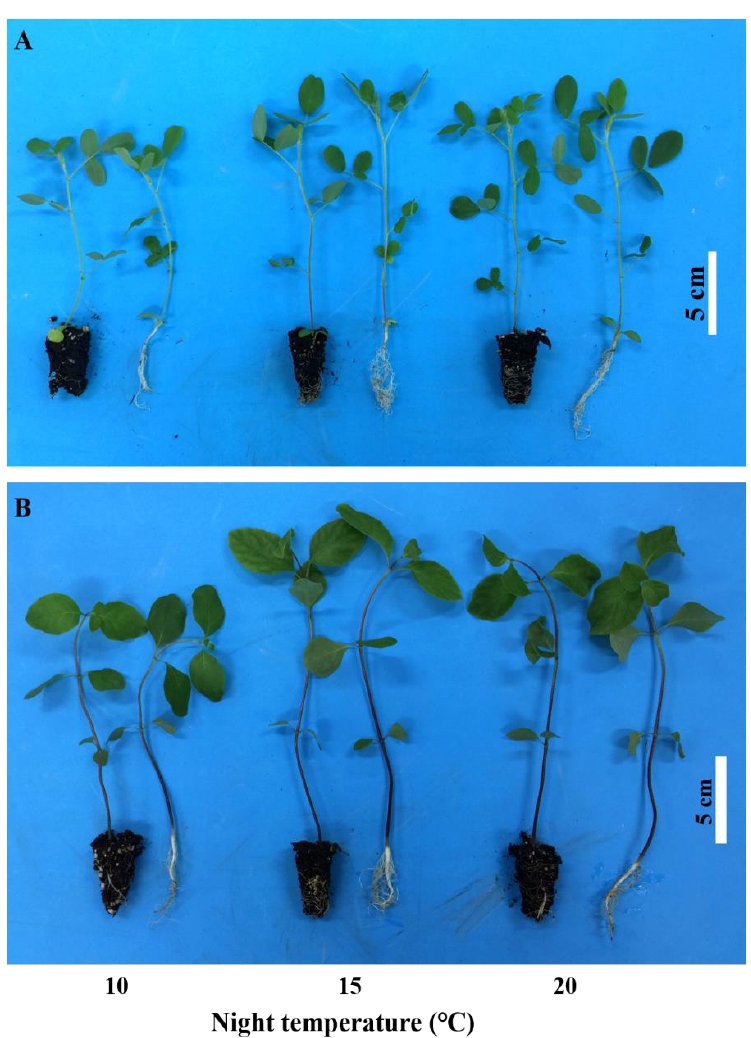
Figure 1. Morphological characteristics of plug seedlings of Astragalus membranaceus ( A ) and Codonopsis lanceolata ( B ) as affected by the night temperature. Bar, 5 cm.